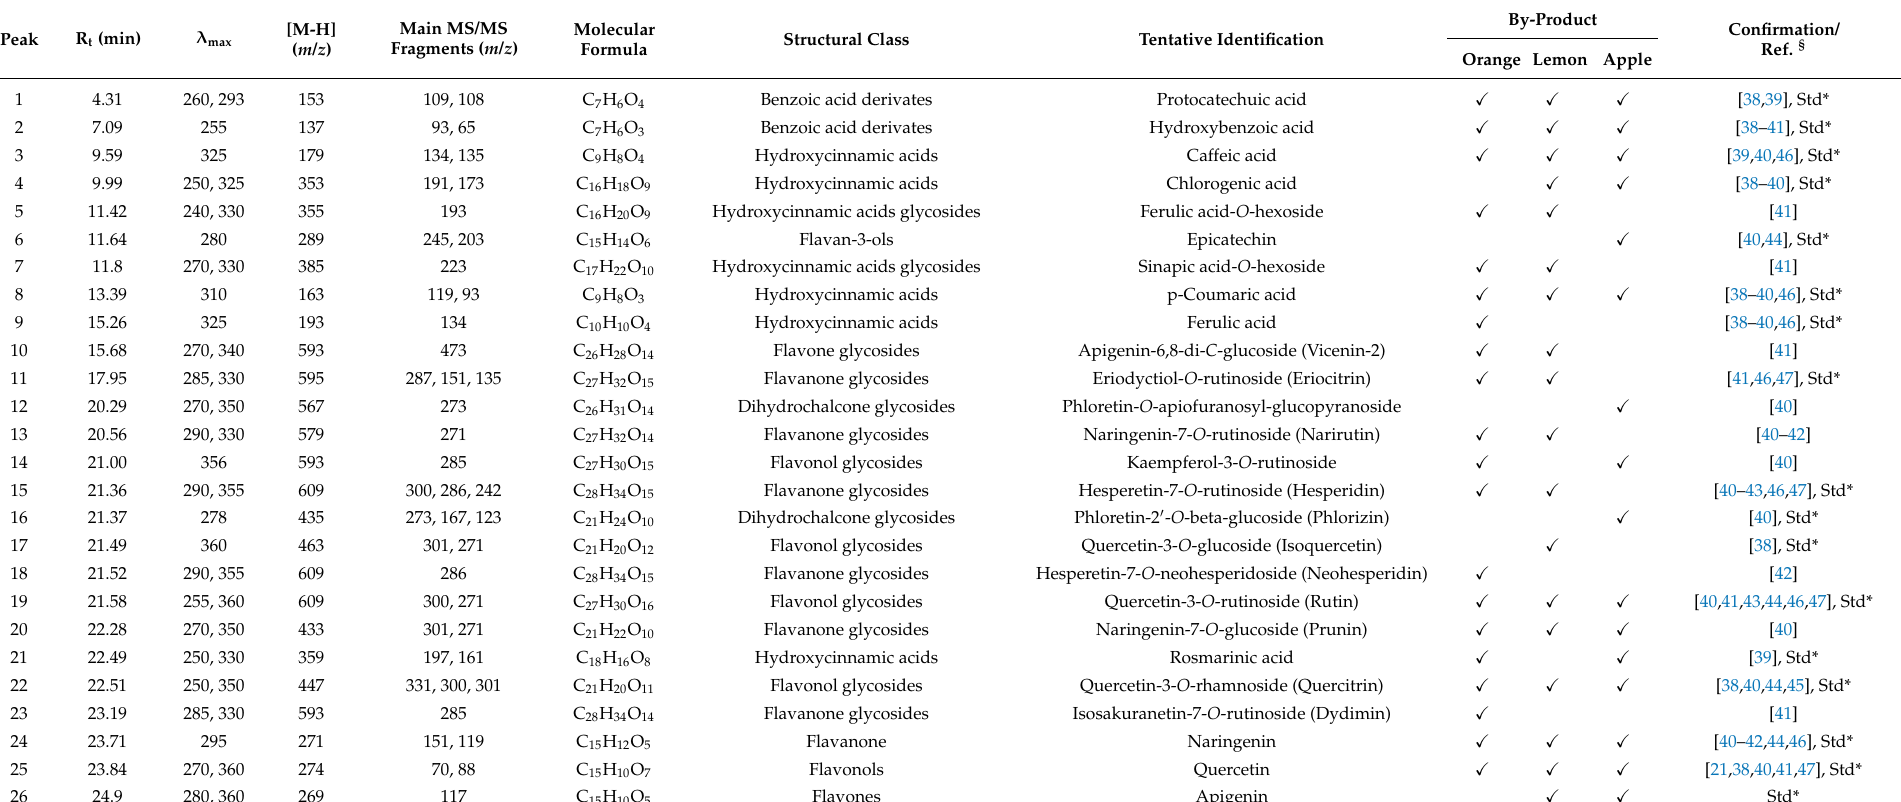
Table 3. Phenolic compounds identified in the fruit by-products from orange, lemon and apple by HPLC-DAD and